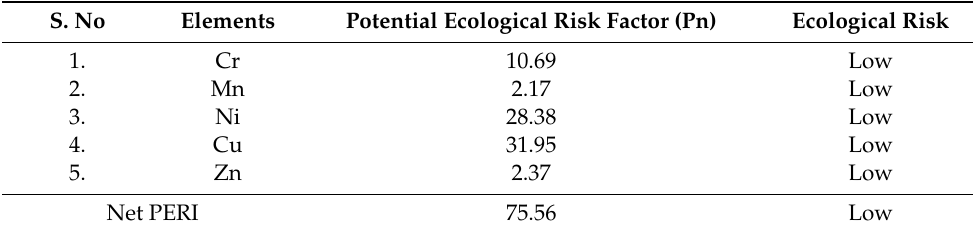
Table 5. Calculated potential ecological risk